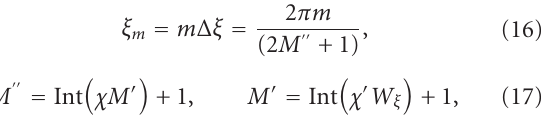
Figure 5: Amplitude of the NF y -component on the line y = 0, z = 12 λ as function of the optimal parameter ξ